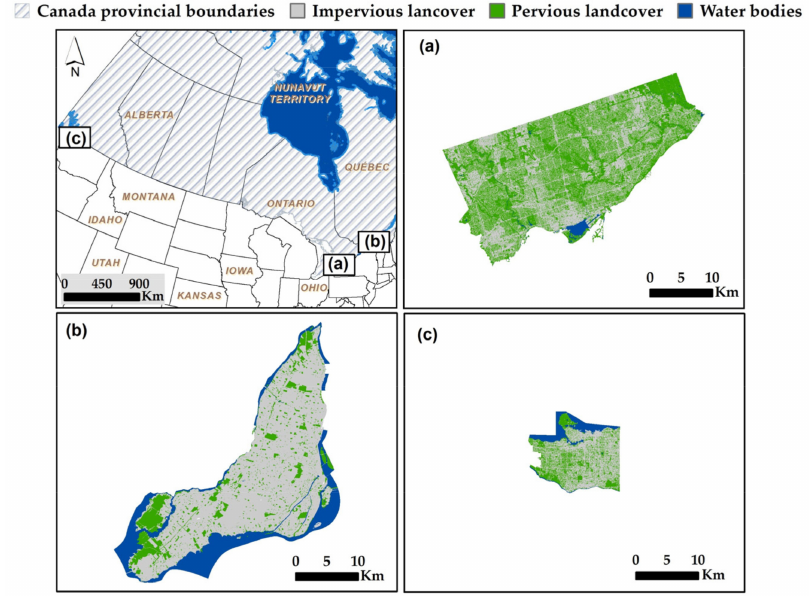
Figure 1. The location of the three case-study cities within Canada showing three land cover categories: ( a ) Toronto; ( b ) Montreal; and ( c )